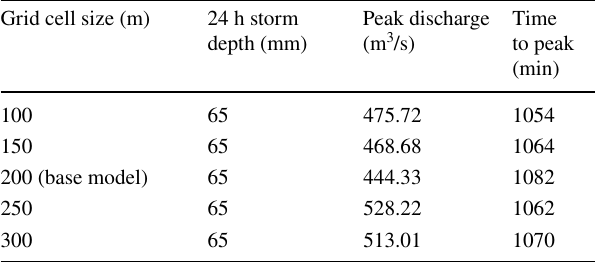
Table 9 Flood properties of calibrated GSSHA base model for a 24-h, 65 mm storm flood compared to hydrographs corresponding to GSSHA models with cell sizes of 100–300 m